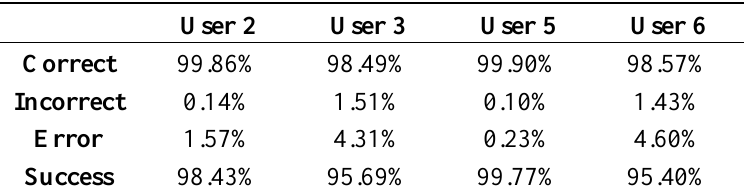
Table 18. Average of annoying sounds I.